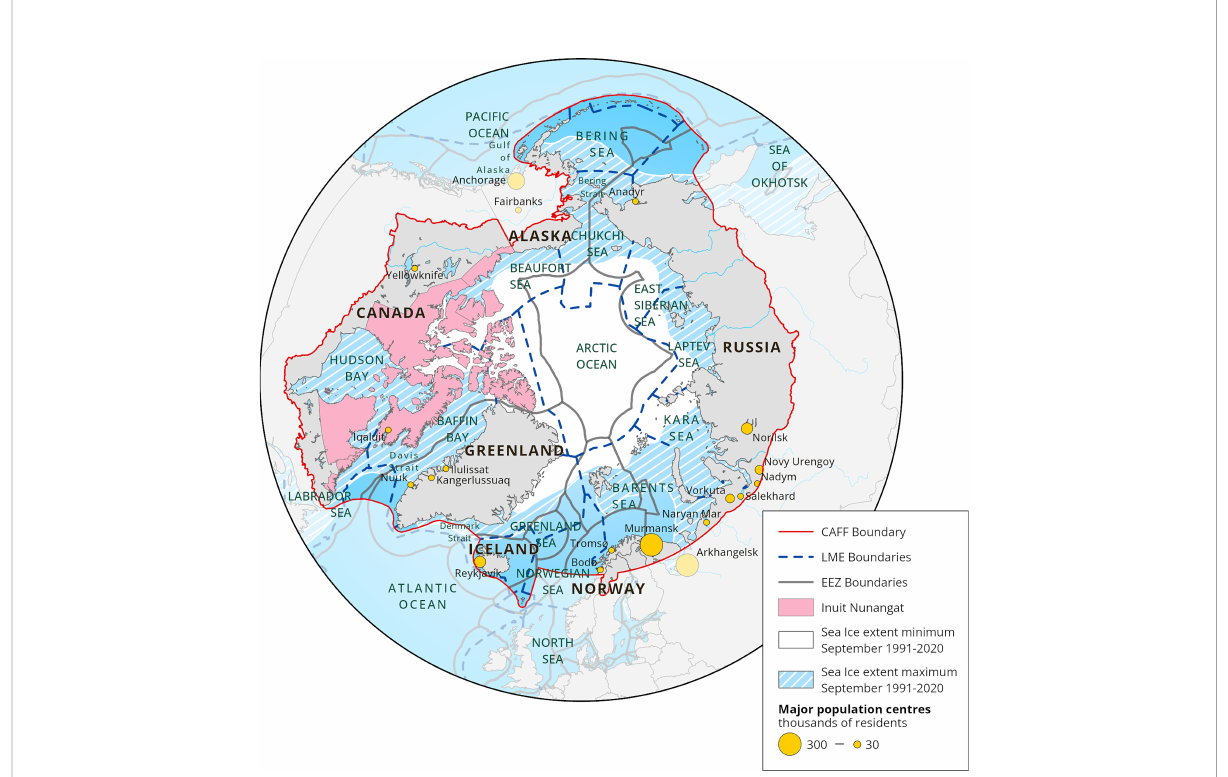
FIGURE 1 Map of the Arctic region depicting the CAFF Arctic boundary as well as Large Marine Ecosystems (LME) identi fi ed by the Protection of the Arctic Marine Environment (PAME) Working Group of the Arctic Council for circumpolar EA application. Inuit Nanungat, major population centers and states ’ Exclusive Economic Zone (EEZ) boundaries are shown for context. IASS/Oceans North visualization based on PAME (2014); CAFF (2017); Flanders Marine Institute (2019); GRID-Arendal (2019); Crown-Indigenous Relations and Northern Affairs Canada (2019); GEBCO Compilation Group (2020); Copernicus Climate Change Service/ECMWF (2021a); Copernicus Climate Change Service/ECMWF